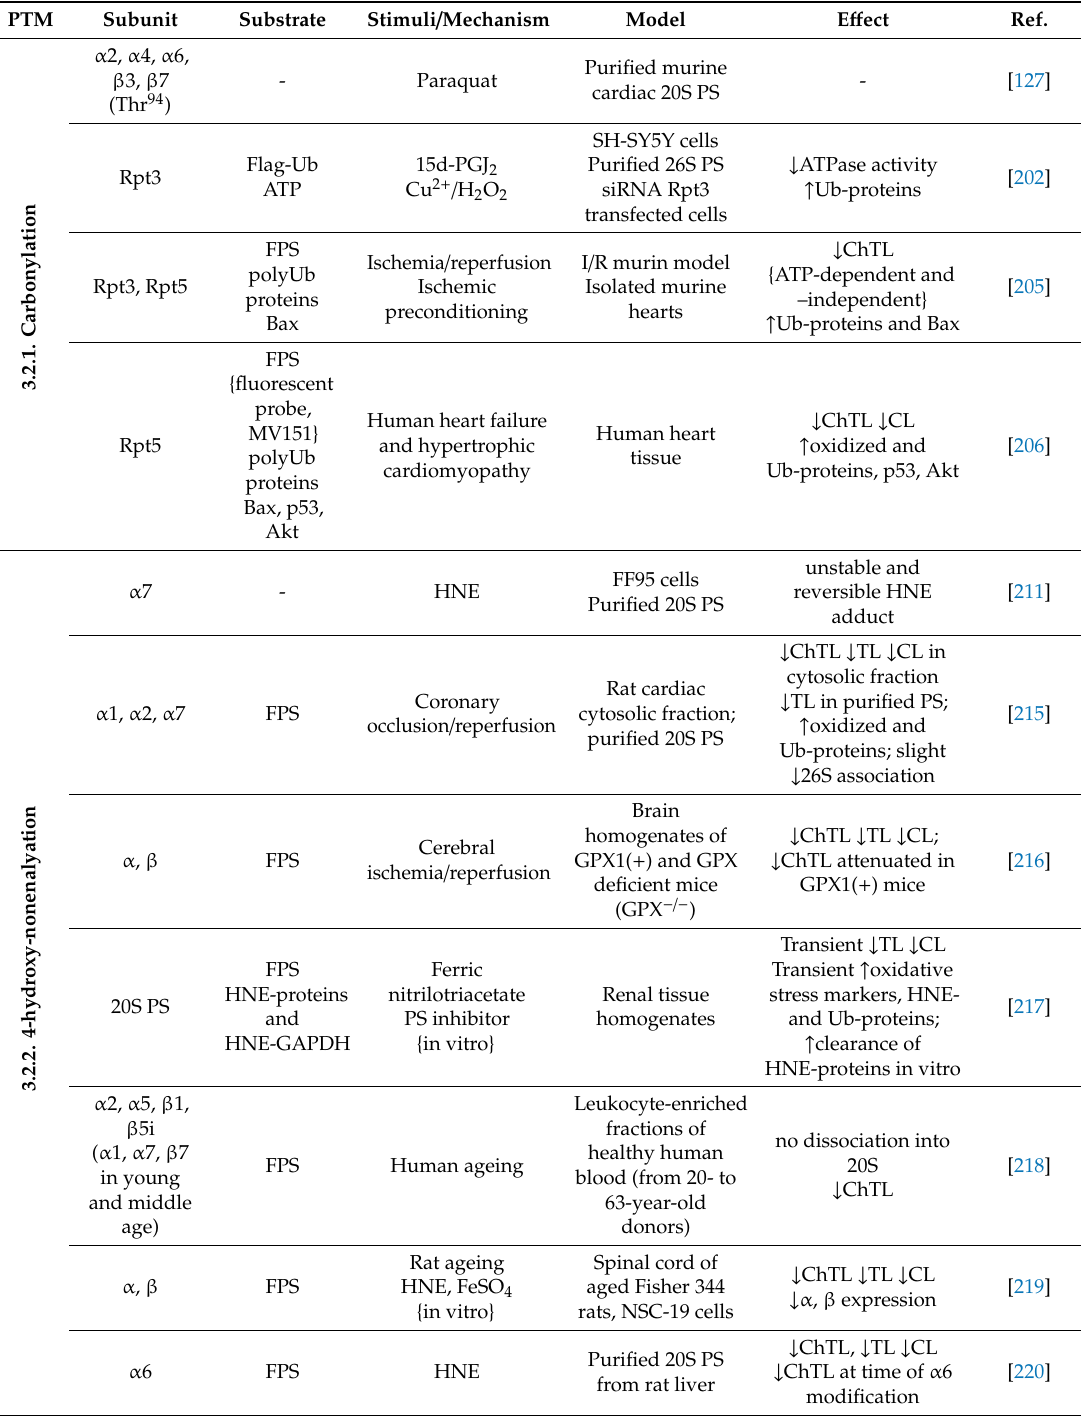
Table 3. ( a ) Posttranslational modifications of proteasome: Carbonylation and 4-hydroxynonenalyation; ( b ) Posttranslational modifications of proteasome: Glycation and tyrosine